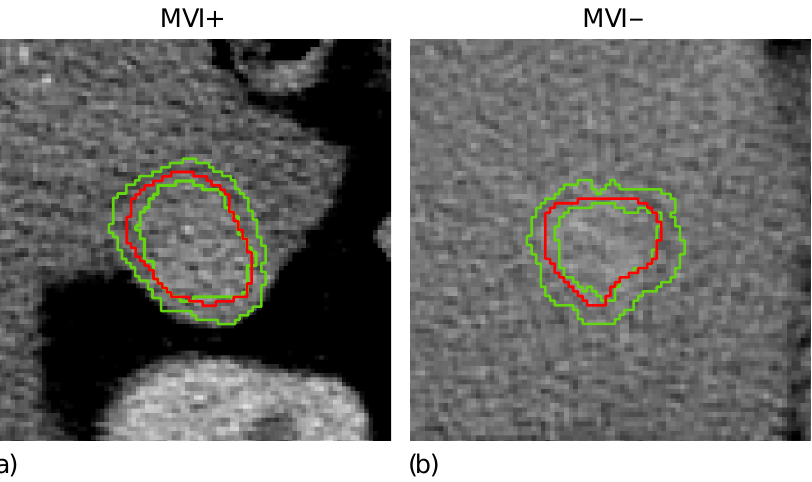
Figure 2. The ZOT is defined between the two green lines for two representative MVI+ ( a ) and MVI − ( b ) nodules; the tumour ROIs are superimposed in red.